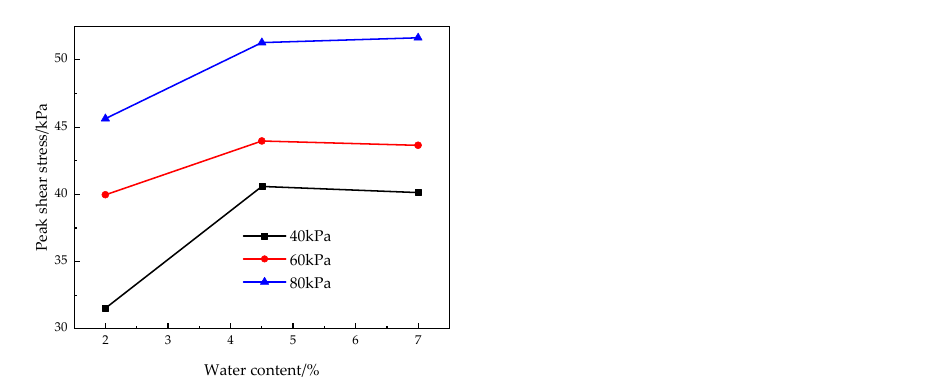
Figure 12. The relationship curve between the shear strength and normal stress of the reinforced soil interface under the freezing state ( − 5 °C).